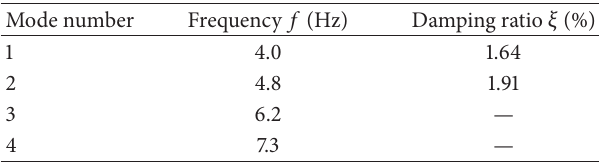
Table 2: Experimental vibration properties of Punta Gennarta Dam—October